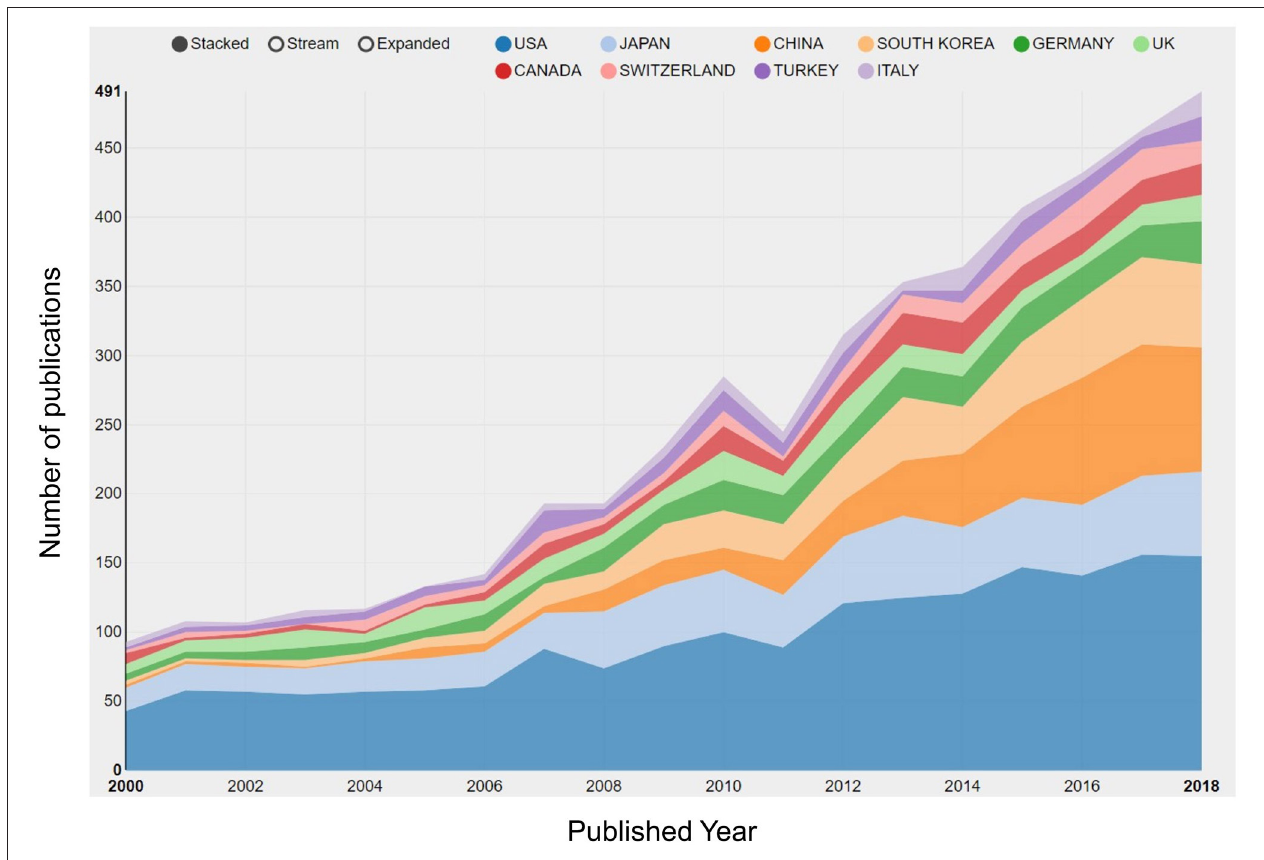
FIGURE 3 | Quantity of relevant literature. The development of the top 10 countries/regions in spinal stenosis from 2000 to 2018.